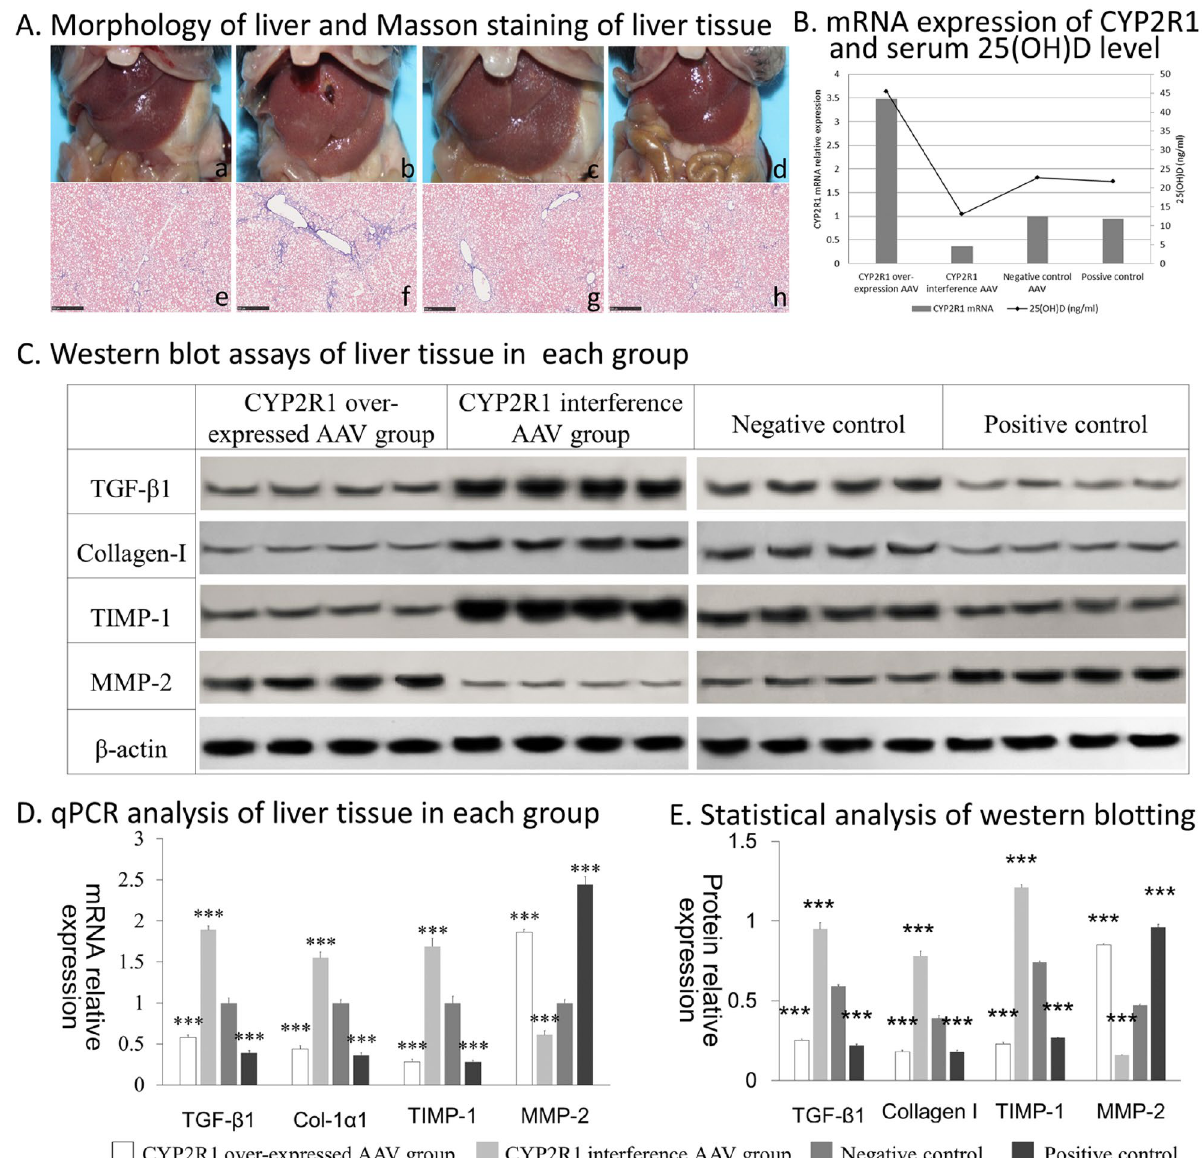
Figure 6. ( A ) morphology of liver and Masson staining of liver tissue: the liver of the CYP2R1-overexpression AAV group (a) and positive control group (d) was ruddy, soft, smooth and the liver capsule was not tense. In the CYP2R1-interference AAV group (b), the liver was enlarged with dark color, hard texture and nodular protuberance on the surface. The liver of negative control group (c) was enlarged, with tight, brown and slightly hard liver capsule. Masson staining of liver tissue of mice showed that there were more blue collagen fibers deposited in liver tissue of the CYP2R1-interference group (f), extending outward from around the vascular region, and the fibers were thicker and the staining was darker. The CYP2R1-overexpression AAV group (a) and positive control group (g) showed less blue collagen deposition in liver tissues. ( B ) mRNA expression of CYP2R1 and serum 25(OH)D level in each intervention group. ( C ) protein level of the liver-fibrosis-related factors in each intervention group detected by western blotting. ( D , E ) statistical results of qPCR and western blotting detection of liver-fibrosis-related factors in each intervention